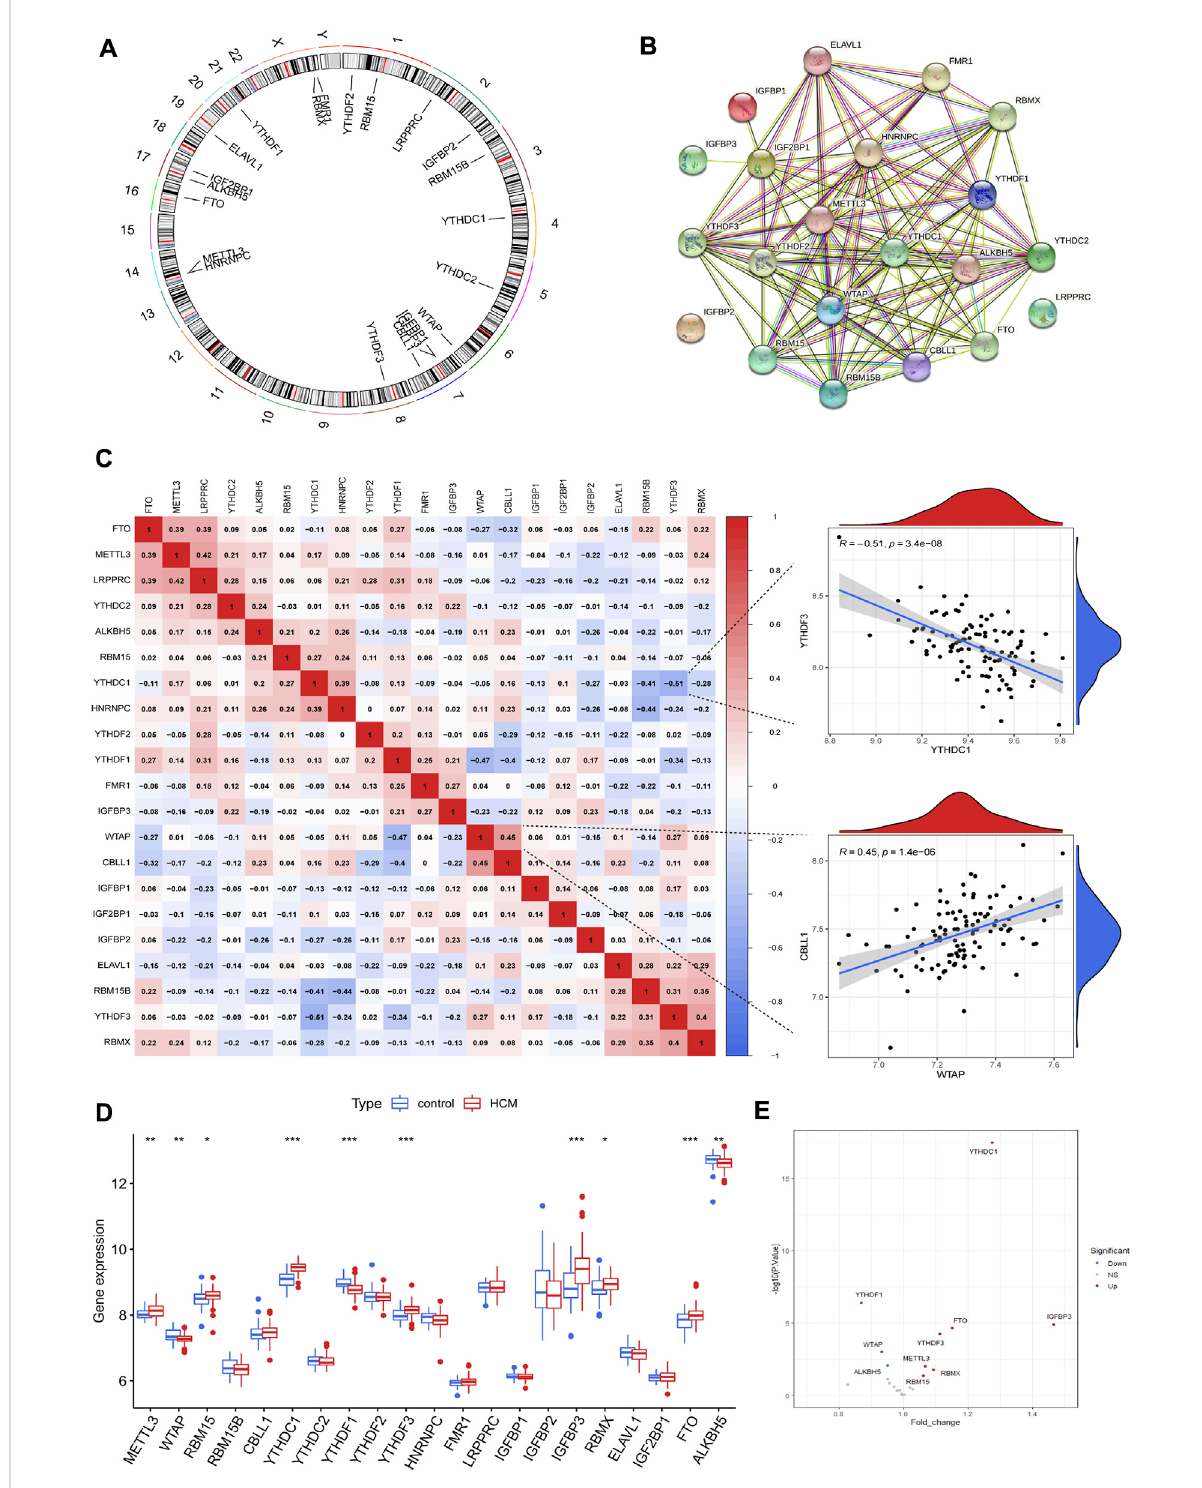
FIGURE 2 The landscape of m6A regulators in hypertrophic cardiomyopathy (HCM) patients. (A) Chromosomal positions of the 21 m6A regulators identi fi ed in cardiac tissues of HCM. (B) Protein-protein interaction network of the m6A regulators. (C) Spearman correlation analysis between the 21 m6A regulators in HCM and the scatterplots showing the two pairs of m6A regulators with the highest positive and negative correlation. (D) Box plot demonstrating the differential expression of 21 m6A regulators between HCM and non-HCM using Wilcox rank sum test. (E) Volcano plot showing a summary of the 10 differentially expressed m6A regulators. * p < 0.05, ** p < 0.01, *** p <